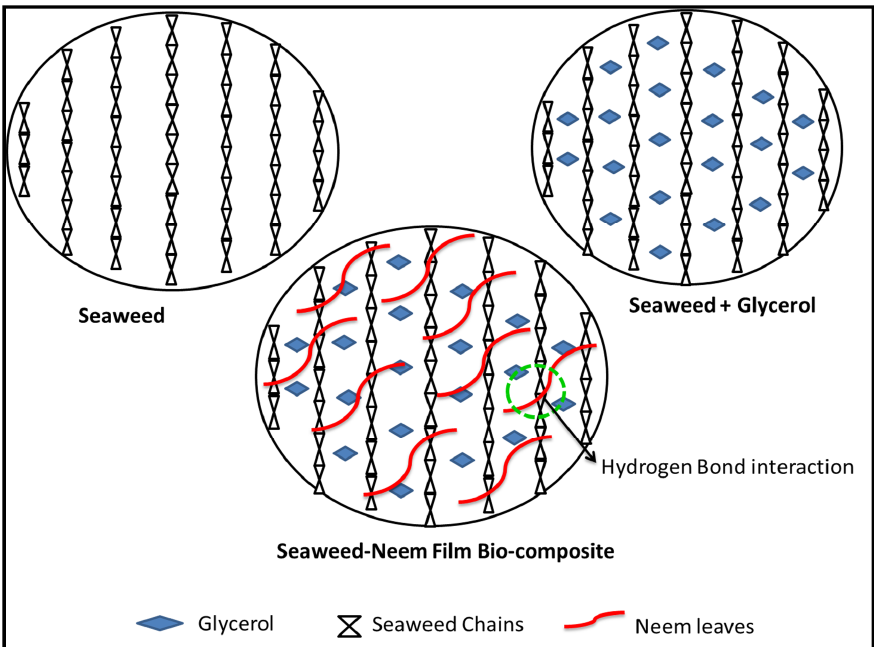
Figure 4. Schematic diagram of seaweed matrix interactions with neem leaves extract. The green circle represents hydrogen bond.